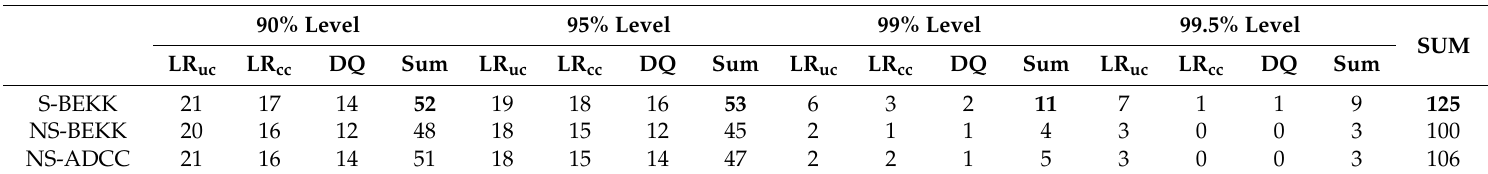
Panel C. w 1 =75%, and w 2 =25% bi-component portfolios